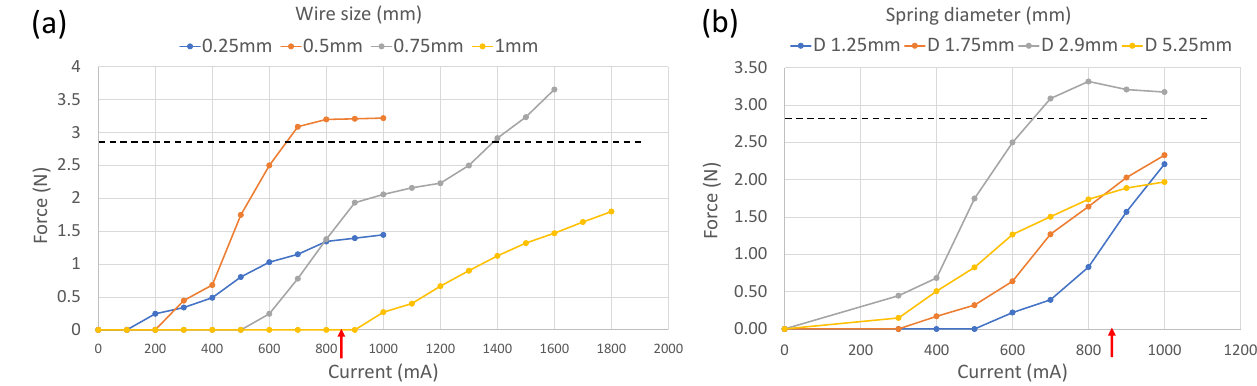
Figure 6. ( a ) Force measurement of different wire sizes at varying currents. ( b ) Force measurements of different spring diameters with 0.5 mm wire size at varying currents. The red arrow on x-axis indicates the amount of drain current supplied by the selected battery. The black line on y-axis indicates the peristaltic forces the SMA spring actuator needs to overcome to anchor at target site.